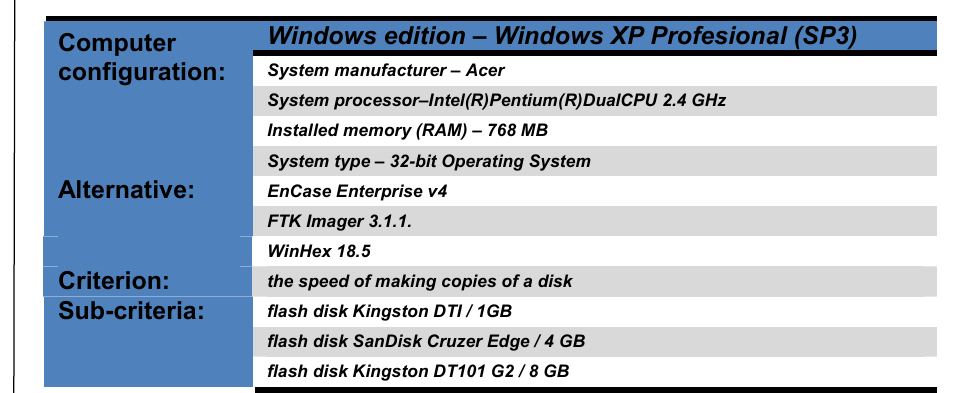
Table 3 – Conditions under which digital forensics software tools -EnCase, FTK and WinHex- are tested, in terms of the time required to copy the disks of 1, 4 and 8 GB Таблица 3 – Условия , в которых испытаны программные обеспечения цифровой форензики EnCase, F ТК и WinHex, с учетом времени , необходимого для создания копии дисков 1, 4 и 8 GB Tabela 3 – Uslovi pod kojima su testirani softveri digitalne forenzike EnCase, FTK i WinHex, sa aspekta vremena neophodnog za izradu kopija diskova od 1,4 i 8 GB